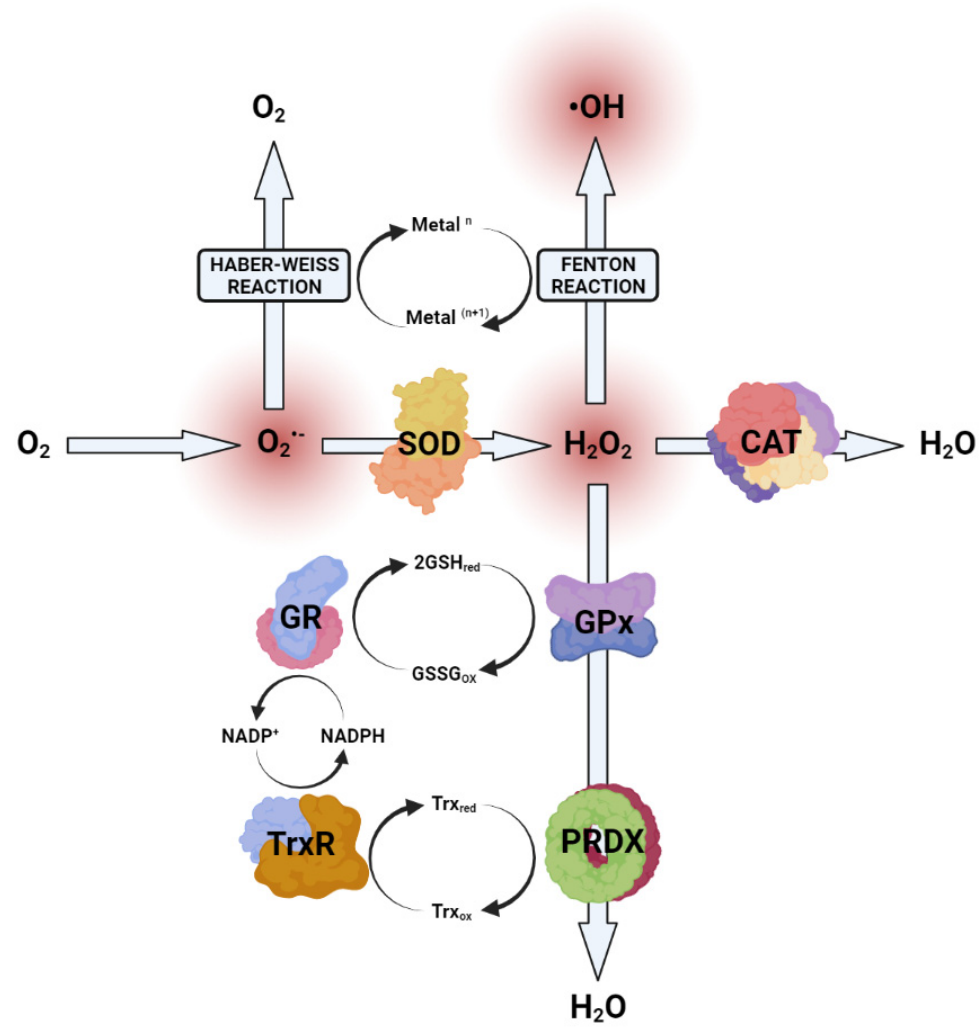
Figure 6. Generation of ROS and the involvement of the enzymatic antioxidative defense system. O 2• − superoxide anion; • OH hydroxyl radical; SOD superoxide dismutase; CAT catalase; GPx glutathione peroxidase; GR glutathione reductase; PRDX peroxiredoxin; TrxR thioredoxin reductase.